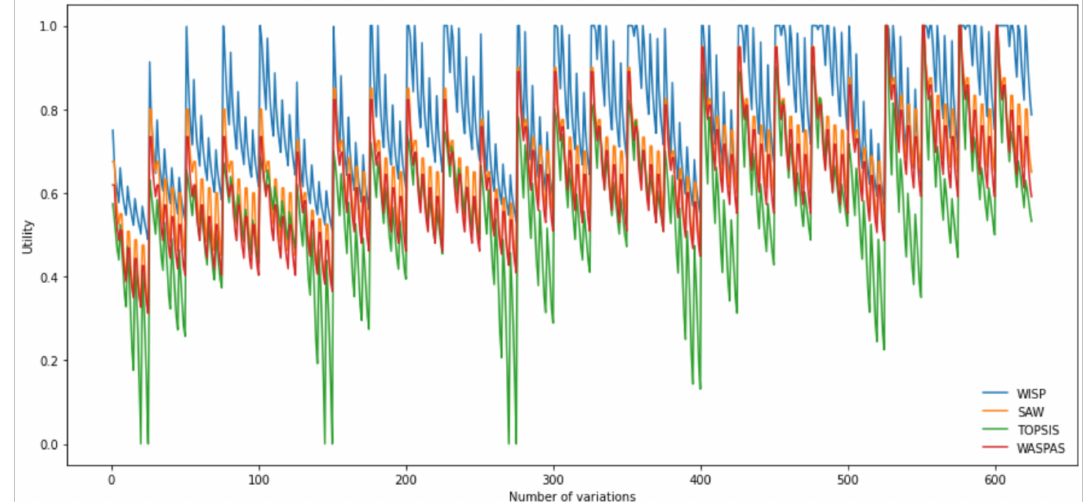
Figure 2. Correlation of utility alternatives achieved by applying different MCDM methods.